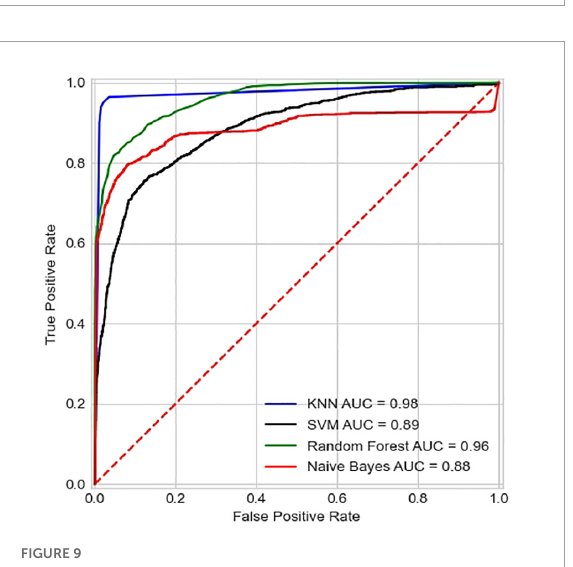
FIGURE8 Confusion matrix of the kNN model. FIGURE9